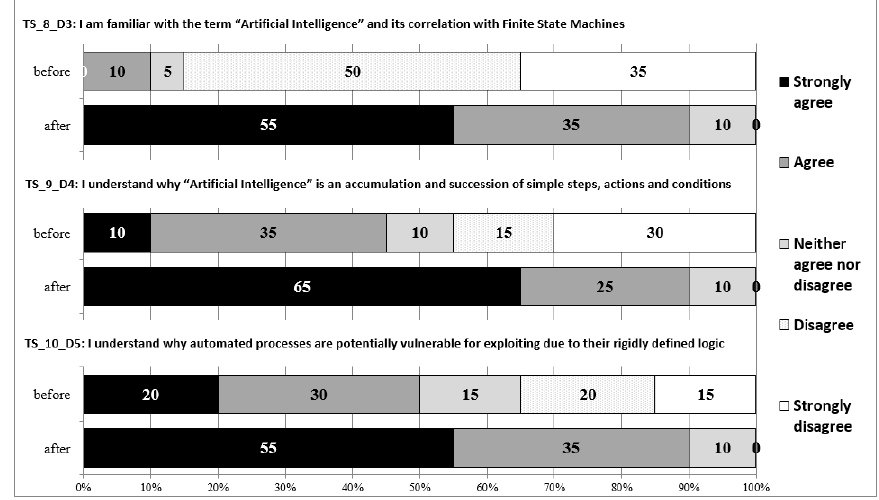
Fig. 5. Results of the answers to the test statements of Category C in the pre-test and the post-